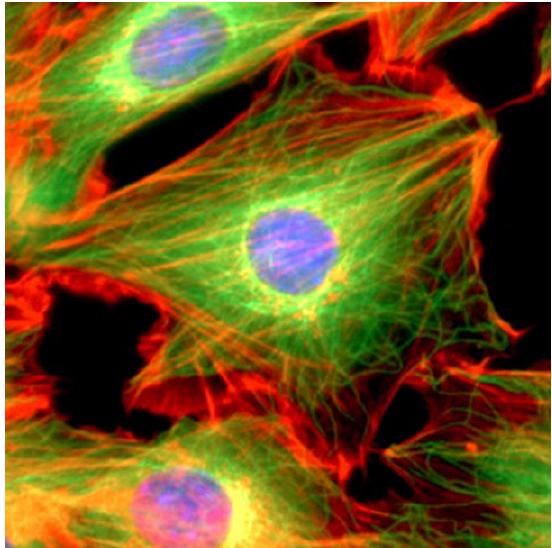
Figure 2. Immunofluorescence image of a 3T3 mouse fibroblast cell showing nuclear DNA (blue), actin microfilaments (red), and alpha-tubulin (green). The illustration is adapted from